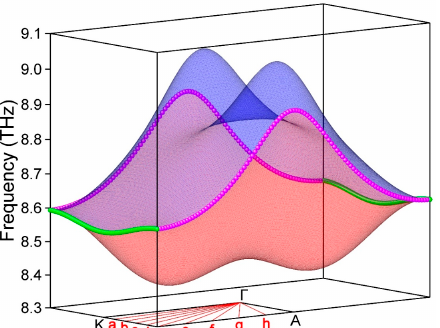
Figure 3. The three-dimensional phononic dispersion surface of the two bands in the middle part for the ternary phosphide compound BaLiP in the k x = 0 plane. The band crossing points at the rectangular border are highlighted with green and purple dots and the coordinate system is shown on the bottom.